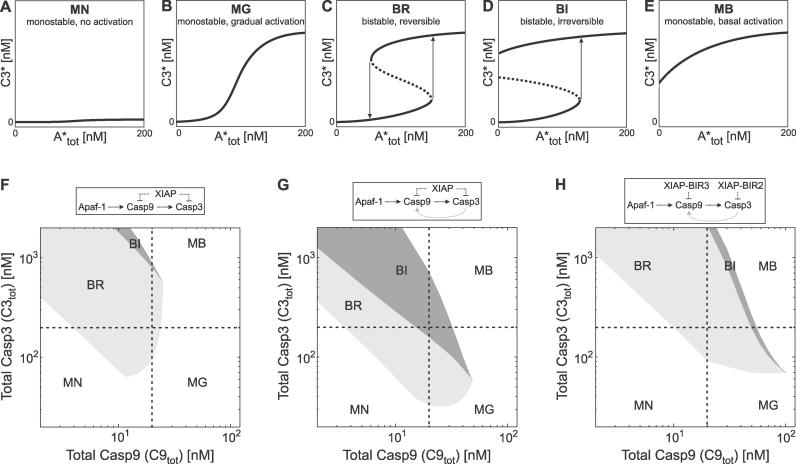
Determinants for Bistability and Irreversibility IThe dose-response curves of the Casp9-mutant model (F), those of the wild-type model (G), and those obtained for noncompetitive caspase binding to XIAP (H) were analyzed for varying Casp3 and Casp9 expression levels. Five types of qualitative behaviour, which are schematically depicted in (A–E), could be distinguished in the physiological range of Apaf-1 expression levels (0–200 nM). The light and dark gray areas in (F–H) correspond to the bistable regions of the model (BR, BI), and the abbreviations MN, MG, and MB indicate the qualitative behaviour outside the bistable region. Experimentally measured caspase concentrations (see Table 1) are highlighted by dashed lines in (F–H).